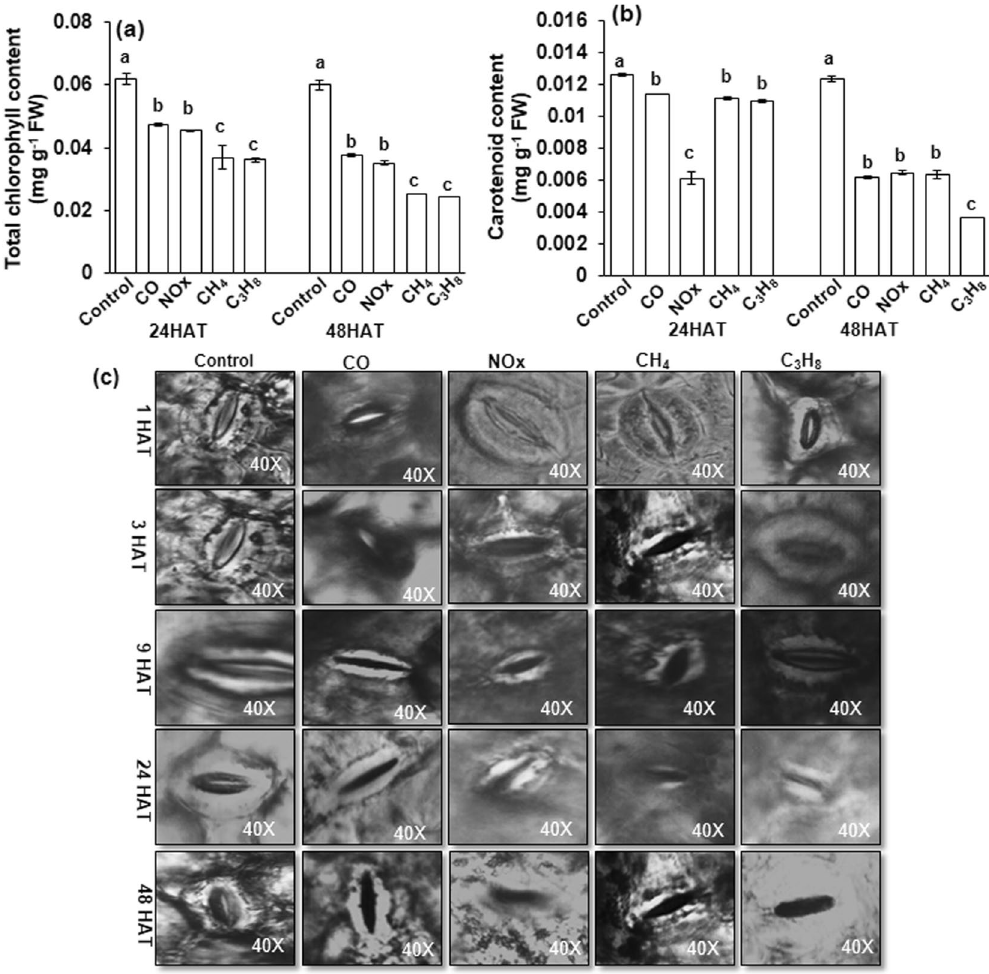
Figure 2. Changes in the content of photosynthetic pigments a total chlorophyll b carotenoid and c representative images of stomata as affected by CO, NO x , CH 4 and C 3 H 8 for 1–48 hours after treatment. Vertical bars indicate ± SE by means with n = 3. Means denoted by the different letter are significantly different at p < 0.05 according to the Tukey’s studentized range test. For stomatal observation thin layer of leaf outer covering were peeled off carefully and laid on a glass slide, covered with a cover slip and were observed under a light microscope Leica CME, Japan at 40X magnification.